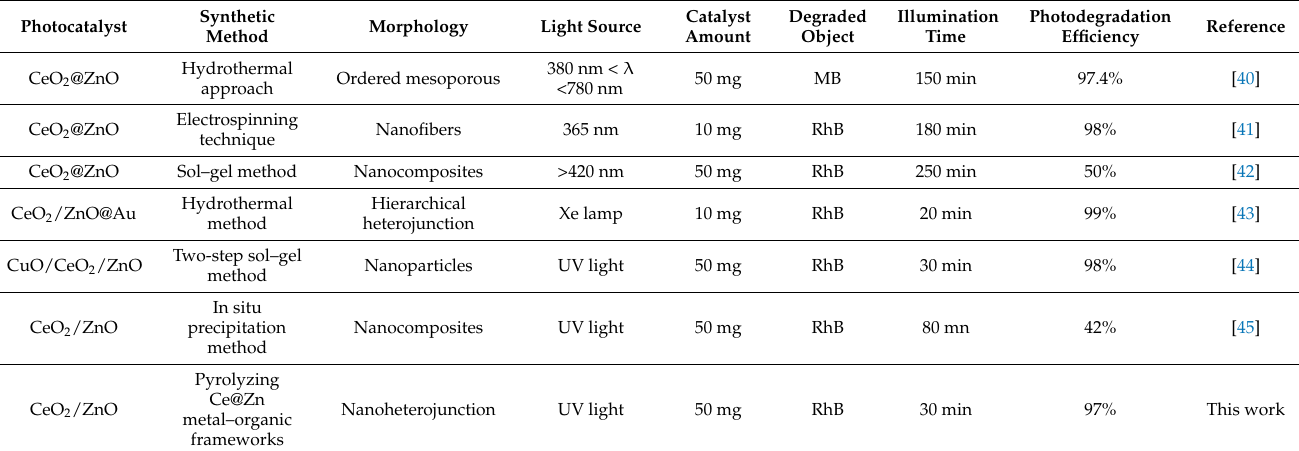
Table 1. Summary of di ff erent synthetic methods of CeO 2 , ZnO, and CeO 2 @ZnO nanomaterials with regard to photodegradation.